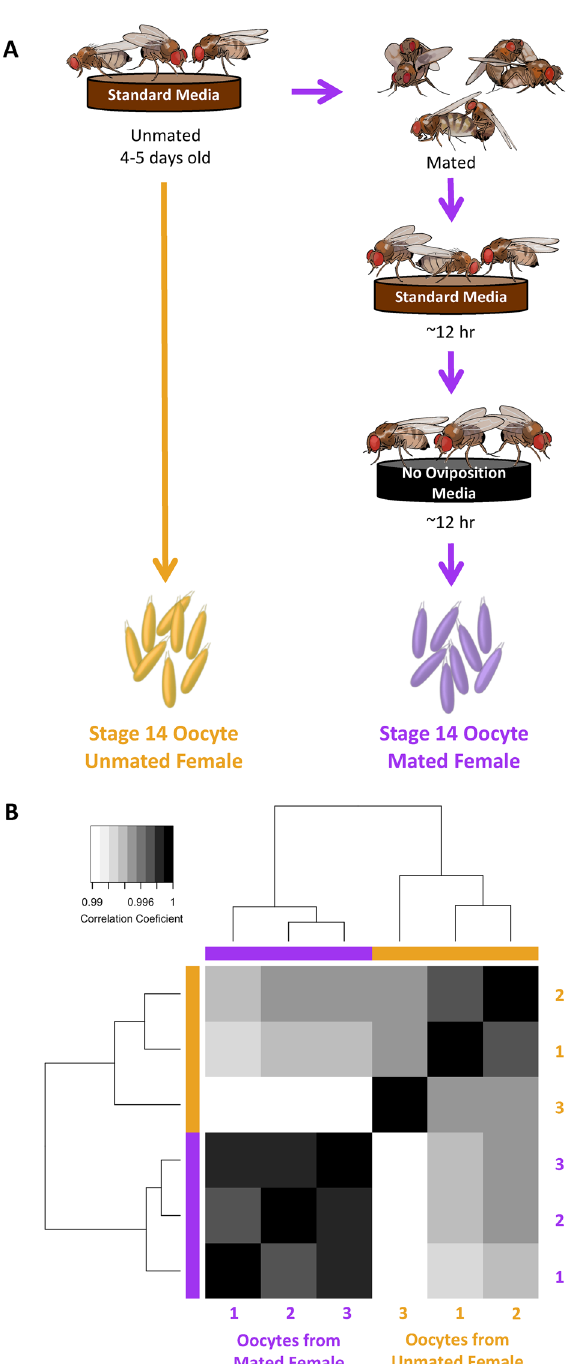
Figure 1. Experimental design and hierarchical clustering of oocyte proteomes. ( A ) Schematic of experimental design (image permission: Siyuan Cong). Oocytes were collected either from unmated females (left) or mated females (right). After mating, females were allowed to ovulate and clear out oocytes that had matured prior to mating and then transferred to a standard no oviposition media for 12hrs to accumulate oocytes that matured in a mated female environment. ( B ) Euclidean distance hierarchical clustering of oocytes proteome replicates based on protein